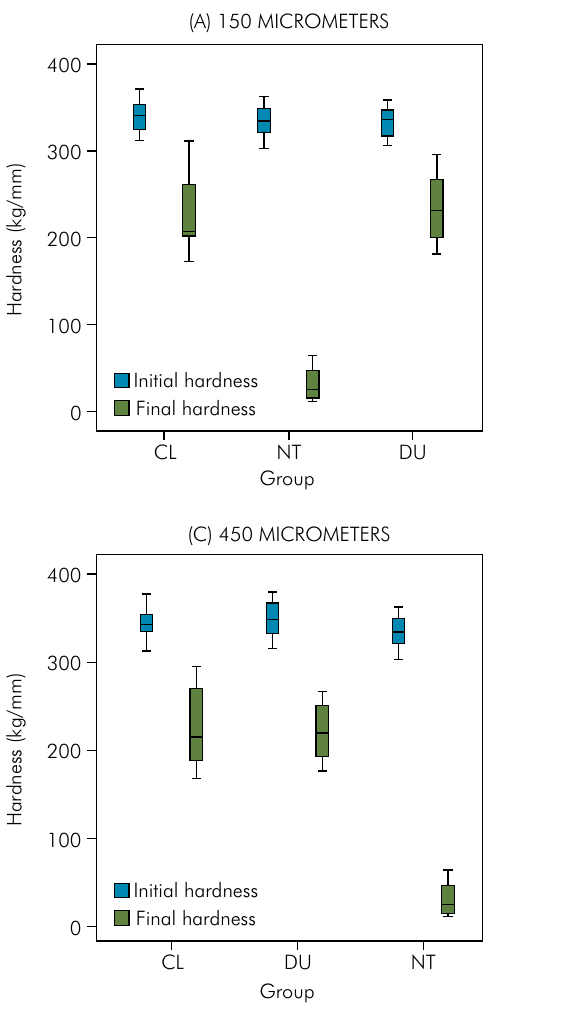
Figure 3. Mean values of initial and final surface hardness at (A)150 μ m, (B) 300 μ m, and (C) 450 μ m from the treatment